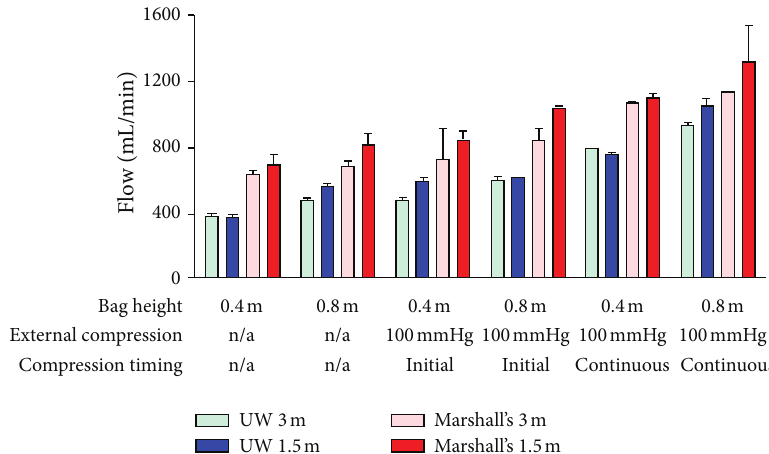
Figure 5: The impact of connecting tubing length on UW and Marshall’s HOC flow (mean and SD) over a range of bag pressures. Data shown is for a system with a cannula size of